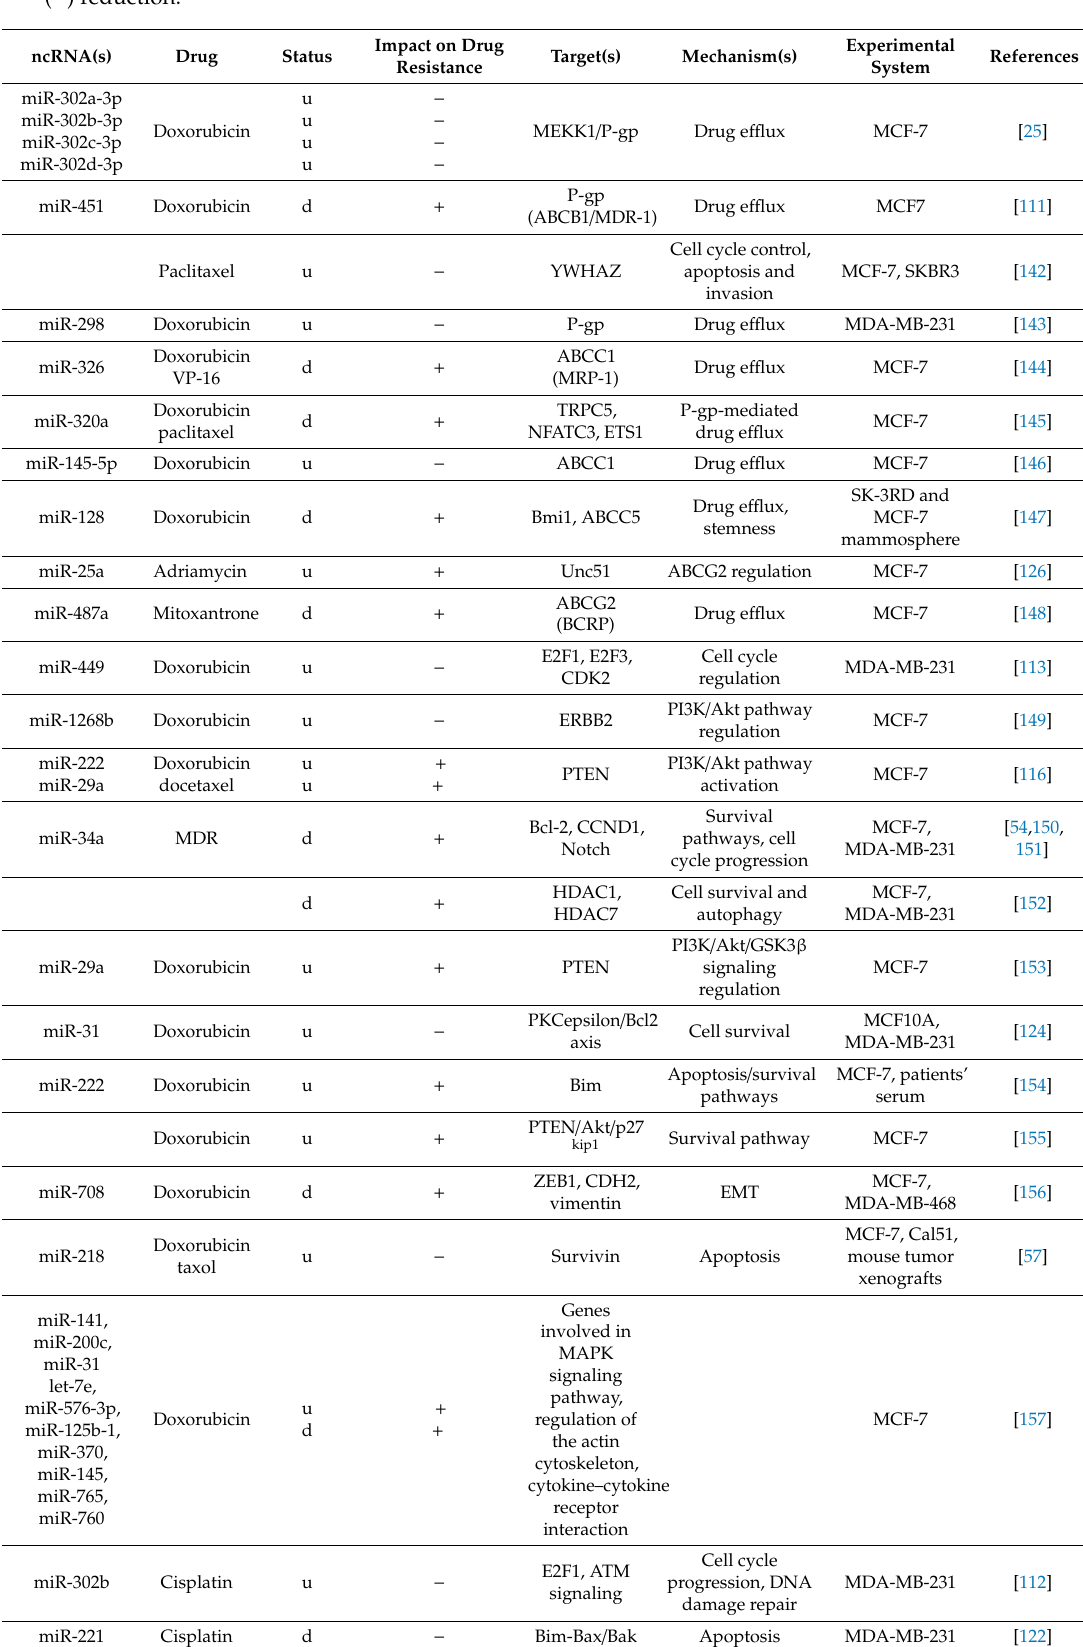
Table 3. miRNAs regulating BC chemoresistance 1 ; (u) upregulated; (d) downregulated; ( + ) increase; ( − )